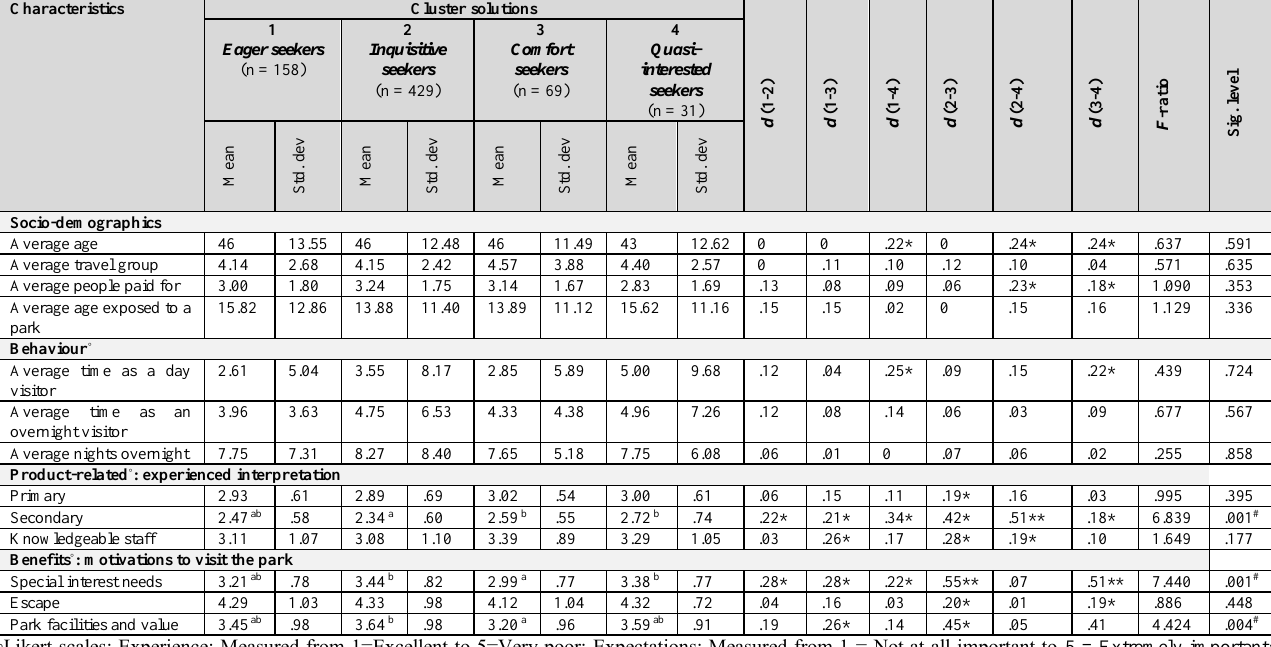
Table 4: ANOVA results for the Kruger National Park’s interpretation segments